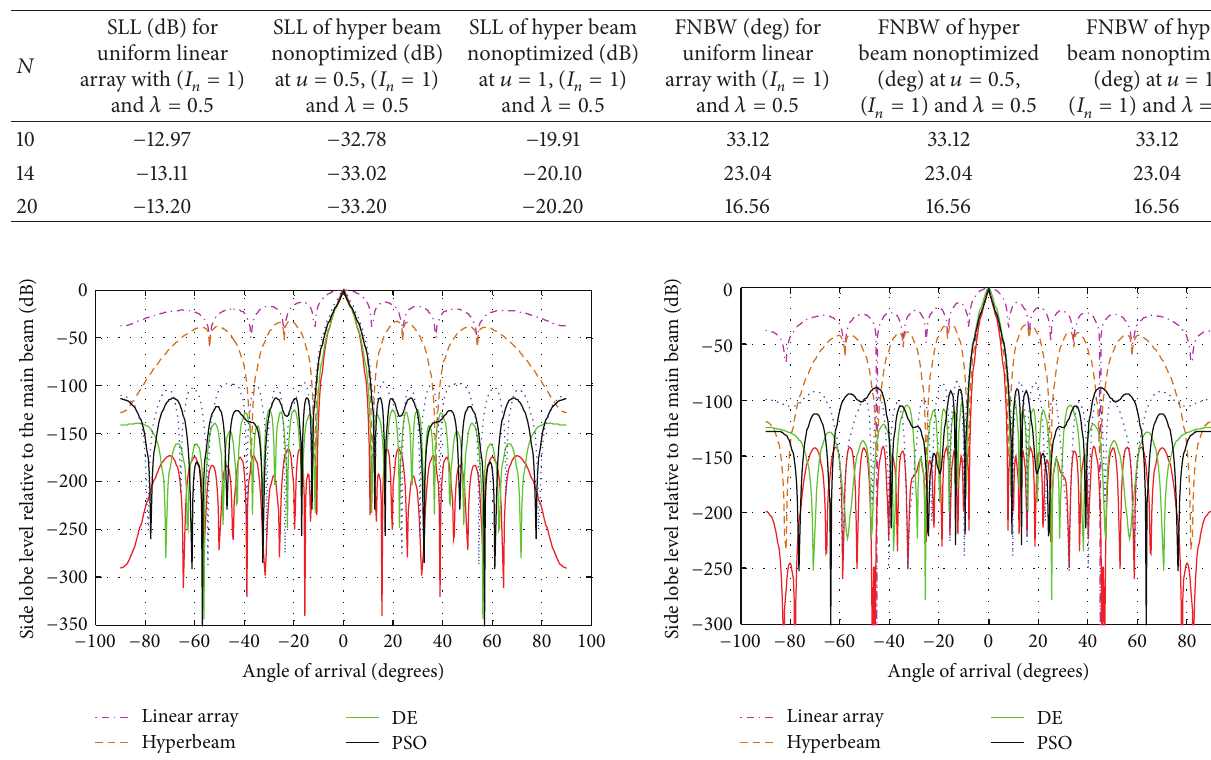
Table 2: Initial values of SLL and FNBW for uniform linear array having uniform excitation (𝐼 𝑛 = 1) and 𝜆/2 inter-element spacing.